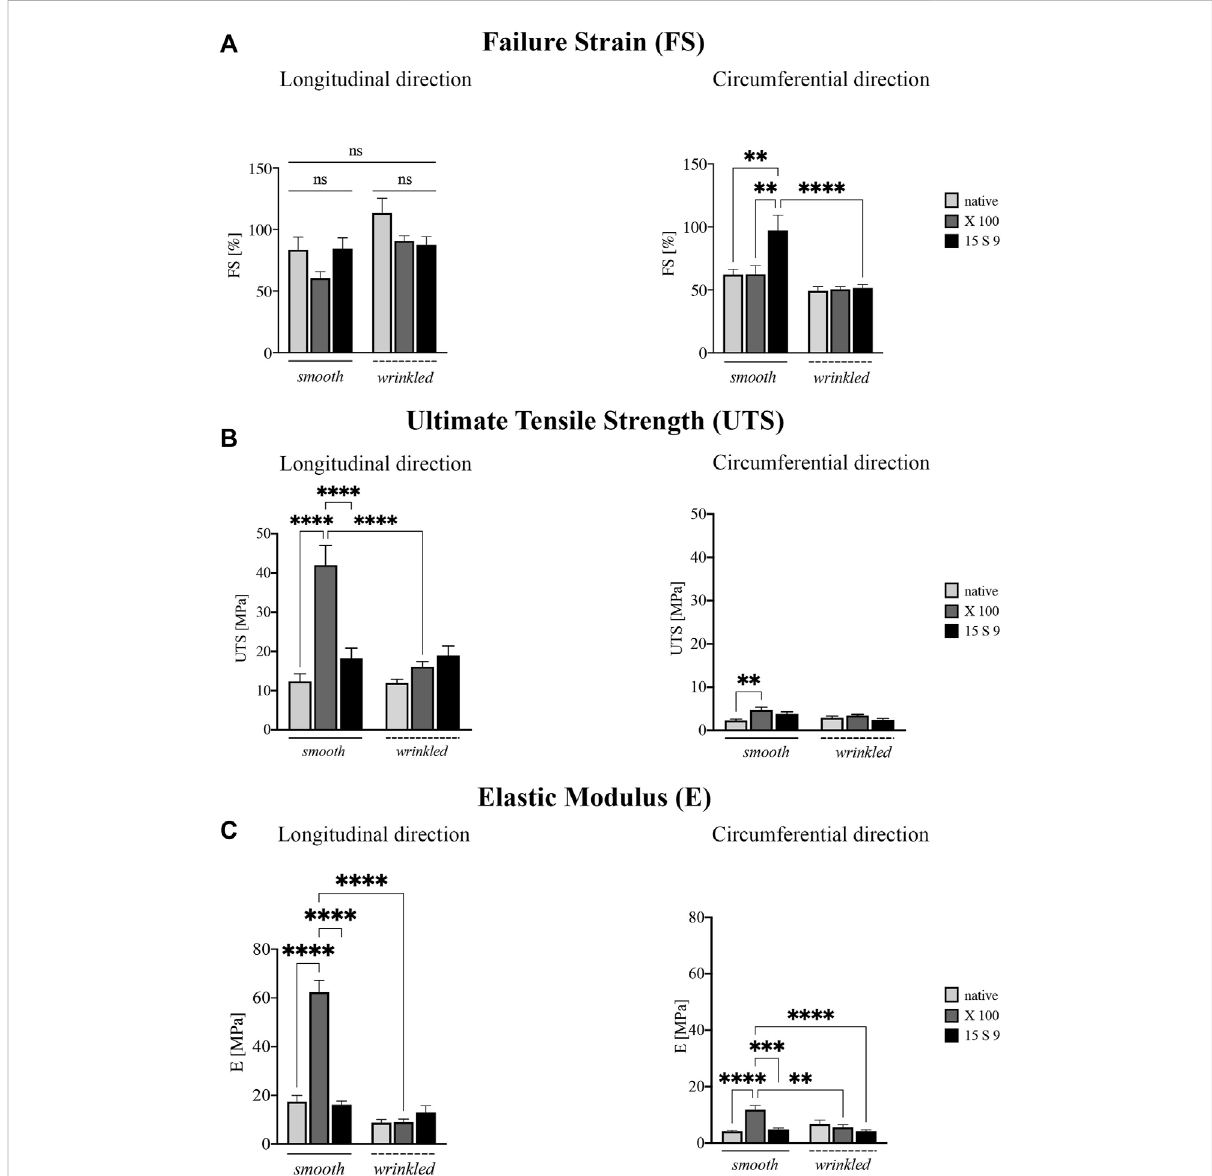
FIGURE 4 BiomechanicalbehavioroftheSISdECMalongthelongitudinalandcircumferentialdirections.Apreservedanisotropy,alongthetwodirections and in the two portions of SIS ( n = 3 for each), was present in all parameter values considered before and after the treatments. (A) Failure strain (FS). Failure strain values along the longitudinal direction were unchanged, while in the circumferential direction, the values after 15 S 9 were signi fi cantly increased, in the smooth compared to the native smooth (** p- value = 0.0035), with X 100 smooth (** p- value = 0.0040) and with 15 S 9 wrinkled ( p- value < 0.0001). (B) Ultimate tensile strength (UTS). X 100 decellularization tended to increase UTS values in the smooth along the longitudinal direction signi fi cantly compared to native smooth, 15 S 9 smooth and X 100 wrinkled (**** p- value < 0.0001). In contrast, along the circumferential direction, the values were very low but signi fi cantly increased in smooth X 100 compared to native smooth (** p = 0.026). (C) Elastic modulus (E). The use of X 100 in the smooth longitudinal portion signi fi cantly increased the stiffness values (**** p- value < 0.0001), compared to the native smooth 15 S 9 and after X 100 wrinkled (**** p- value < 0.0001). Also, along the circumferential, the stiffness values of smooth X 100 were increased compared to native smooth and 15 S 9 wrinkled (**** p- value < 0.0001) and compared to smooth 15 S 9 (*** p- value = 0.0002) and wrinkled X 100 (** p- value = 0.0012). The parameter values are considered (FS, UTS, and E) as mean ± standard deviation, for each treatment, in the smooth and wrinkled portions and along the longitudinal and circumferential directions. X 100: Triton X 100.15 S 9: Tergitol 15 S